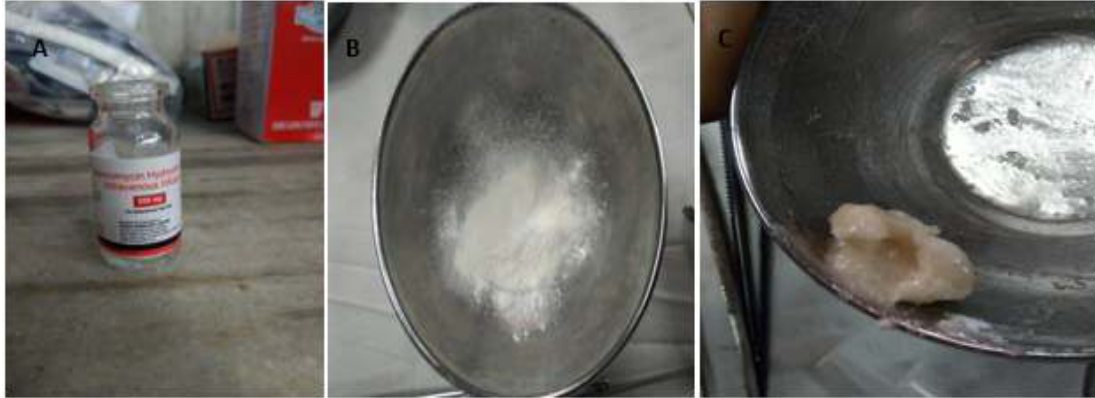
Figure 1: Vancomycin and its paste after mixing with saline.